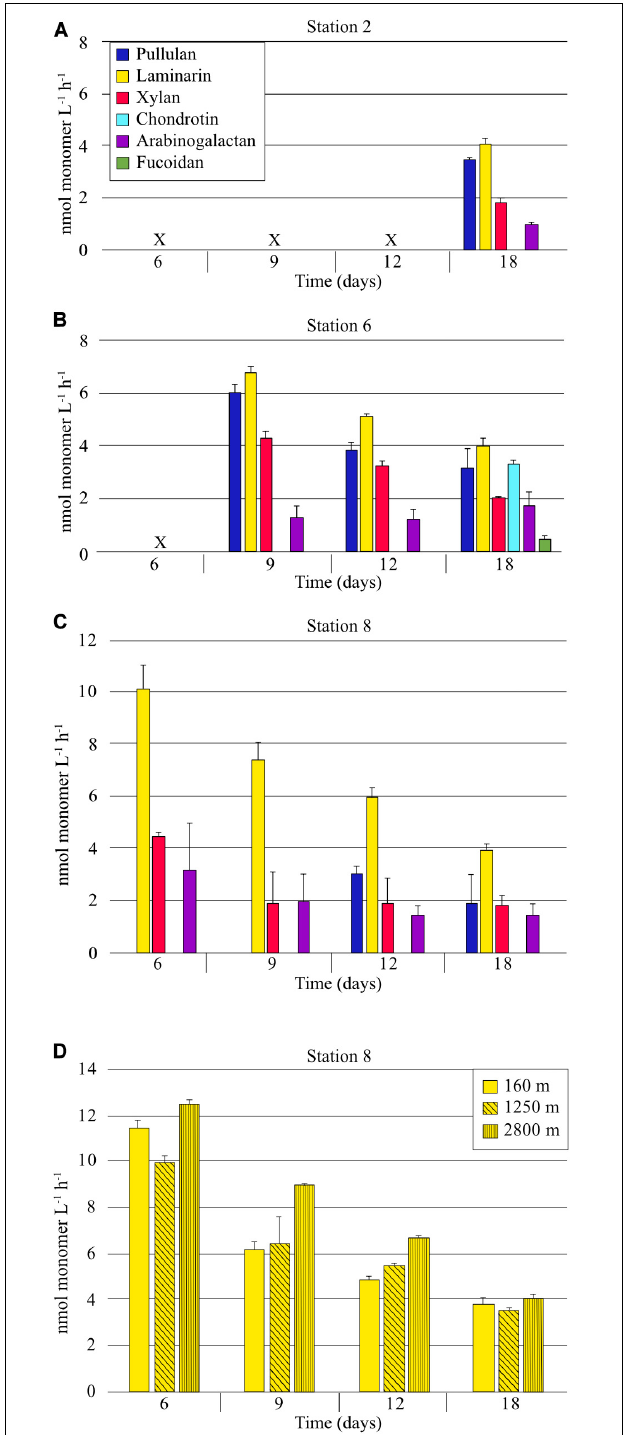
FIGURE 2 | Extracellular enzymatic hydrolysis rates of polysaccharides in samples collected from a depth of 75 m at (A) Stn. 2 (B) Stn. 6, (C) Stn. 8. (D) Extracellular hydrolysis rates of laminarin in water collected from depths of 160, 1250, and 2800 m at Stn. 8. X indicates that no sample was available (see section “Materials and Methods”). Error bars show standard deviation between triplicate